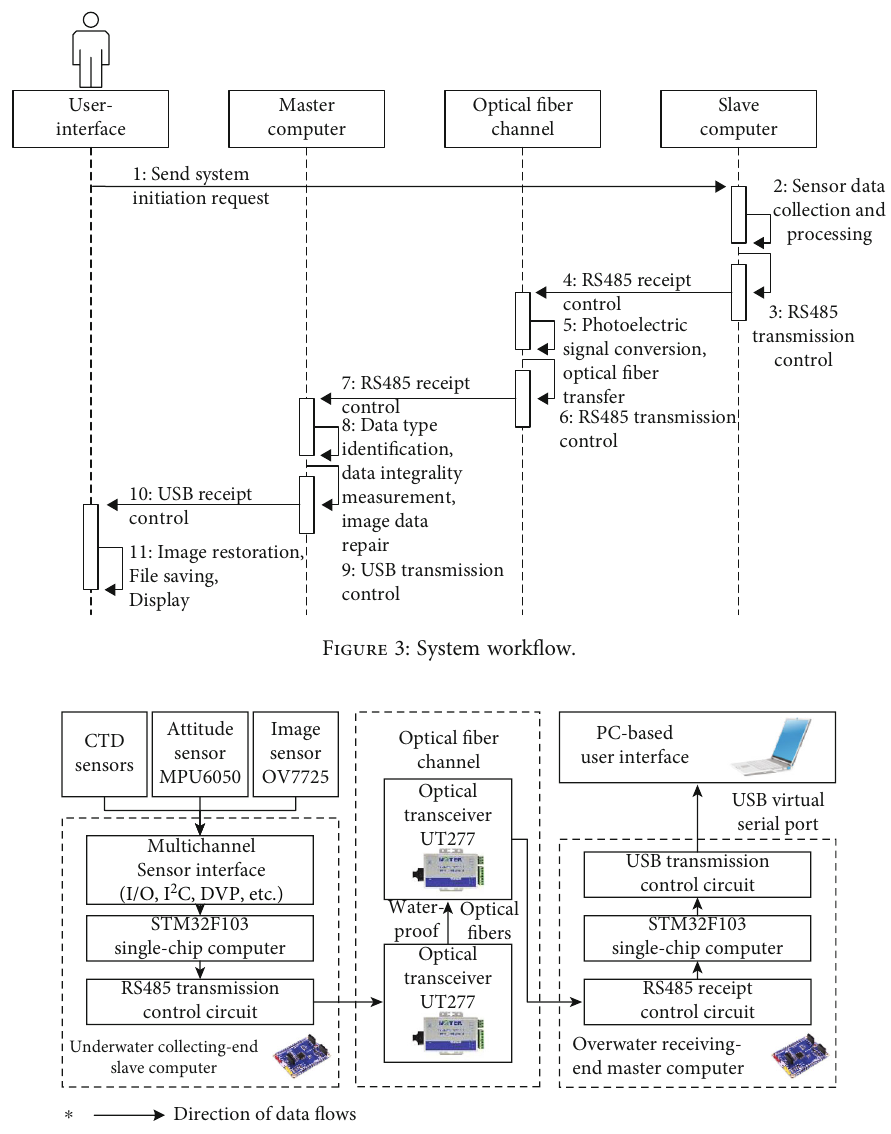
Figure 4: Hardware block